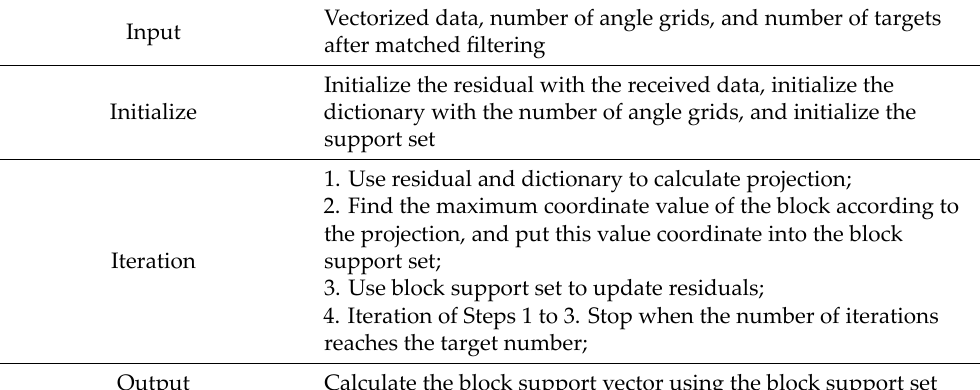
Table 1. Calculation process of BOMP